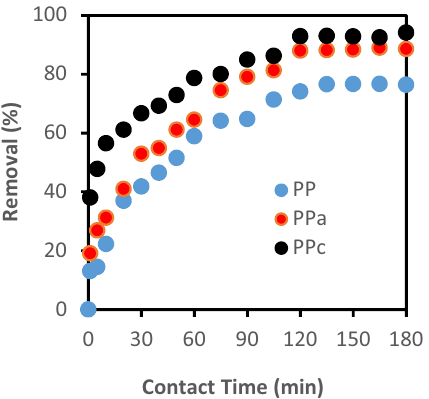
Figure 7. Effect of contact time on the sorption of CB onto native, activated and calcined sorbents at pH = 2.2 (C 0 = 30 mg/L; m (PP) = m (PPa) = 2 g/L; m (PPc) = 0.6 g/L; T = 25 ± 2 °C).